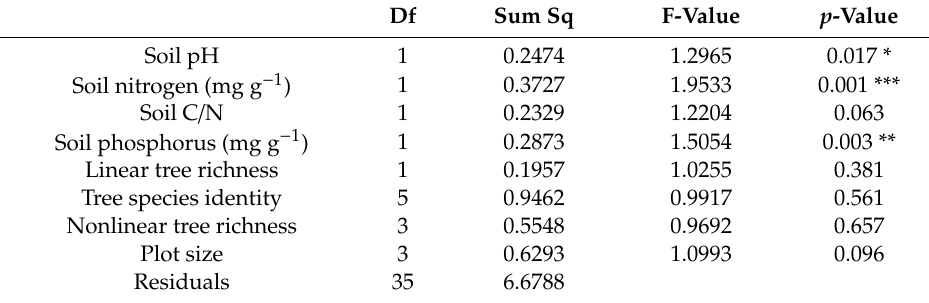
Table 3. ANOVA-like permutation test for distance-based redundancy analysis (dbRDA) of the fungal community composition (999 permutations). Df: degrees of freedom, Sq: square, C / N: carbon-to-nitrogen ratio, *** p < 0.001, ** p < 0.01, * p < 0.05. Nonlinear tree richness is an approximation for interactions among tree species, independent of their